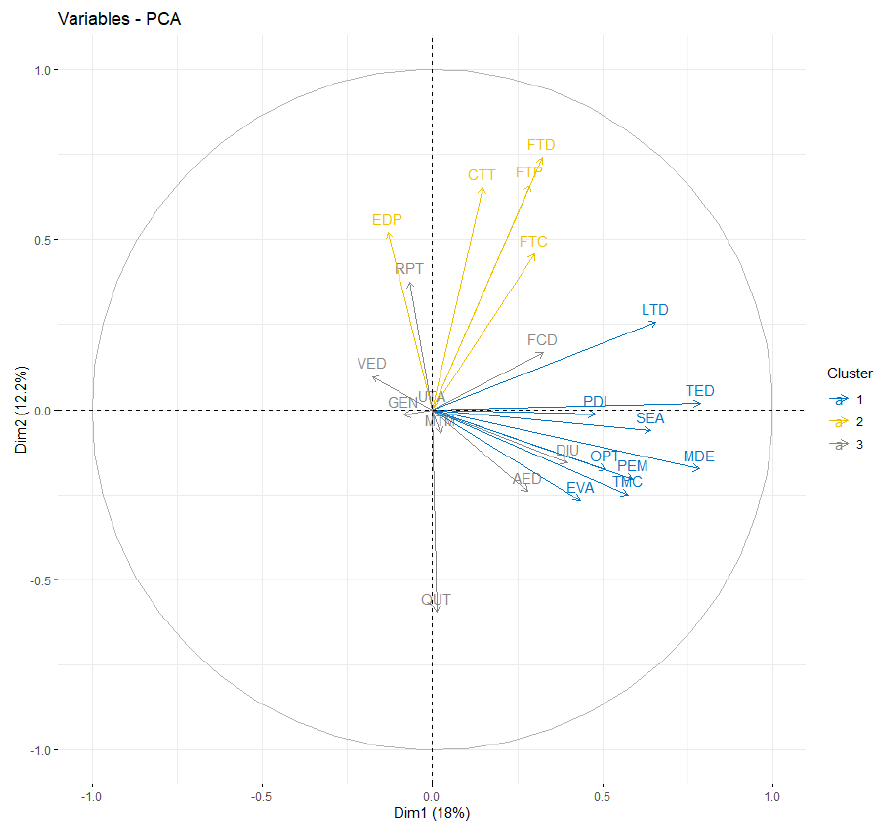
Figure 5. Cluster classification (by color) of study items using PCA.